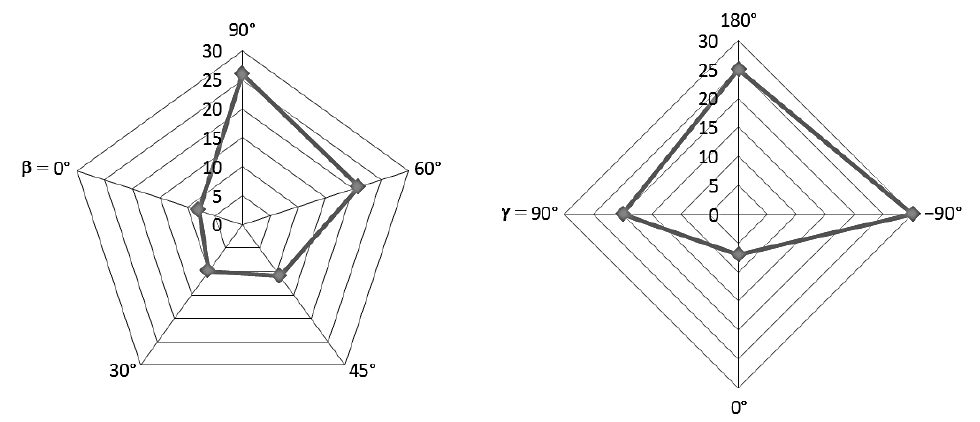
Figure 5. Average values of the percentage deviations, derived by grouping the data (measured and calculated) obtained for the same β values ( left side chart ) and for the same γ values ( right side chart ).